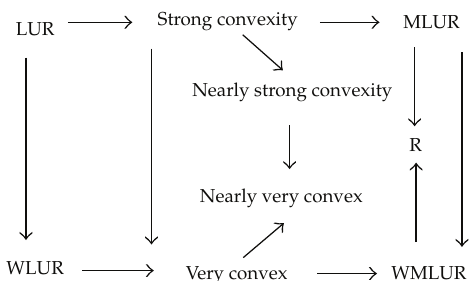
Figure 1: The relationship between the